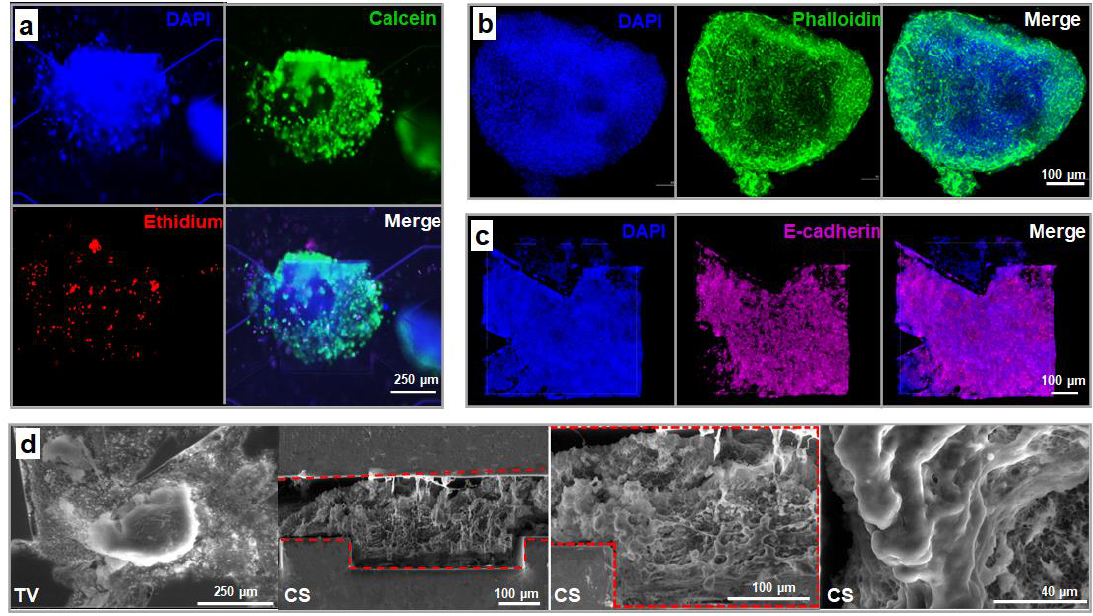
Figure 7. Characterization of HepG2/C3A spheroids after 21 days of dynamic culture in a biochip containing a hydroscaffold. ( a ) cell viability: DAPI (nuclei, blue), calcein (living cells, green) and ethidium (dead cells, red); ( b ) F-actin staining: DAPI (nuclei, blue) and phalloidin (F-actin, green); ( c ) E-cadherin staining: DAPI (nuclei, blue) and E-cadherin (purple); ( d ) SEM observation (TV: top view and CS: cross section). The immunostaining images ( b , c ) correspond to z-stack